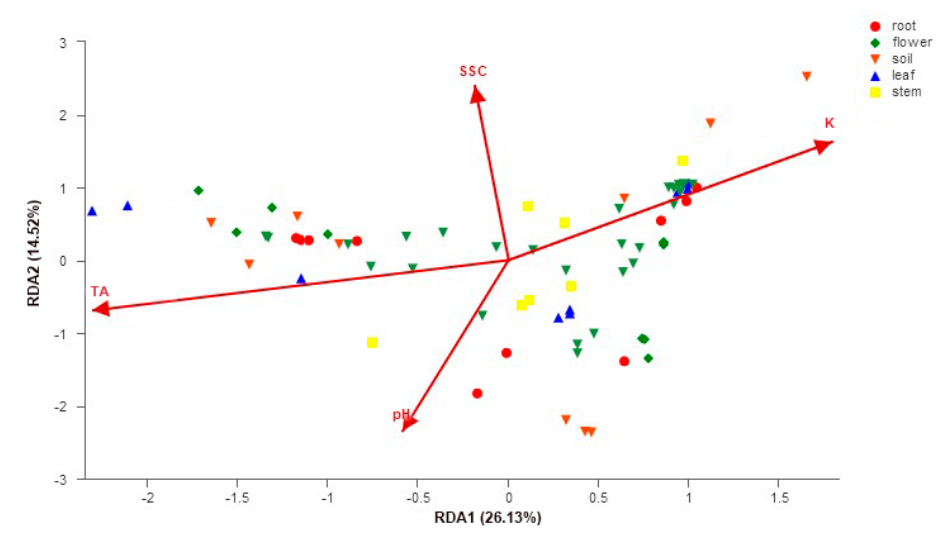
Figure 6. Redundancy analysis (RDA) plot showing the correlation between fungal community structure and soil properties and peach fruit properties. SSC—soluble solid content, TA—titratable acidity.